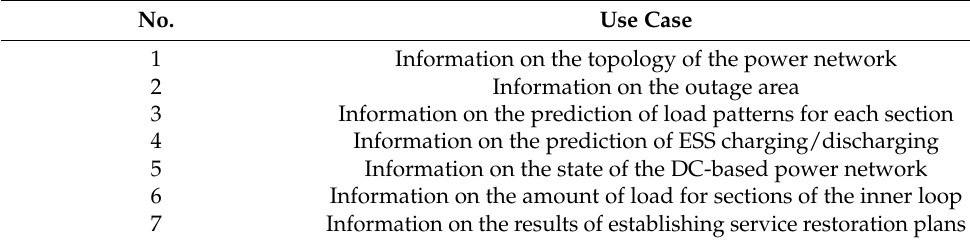
Figure 7. The scenario of the use case for establishing service restoration plans.